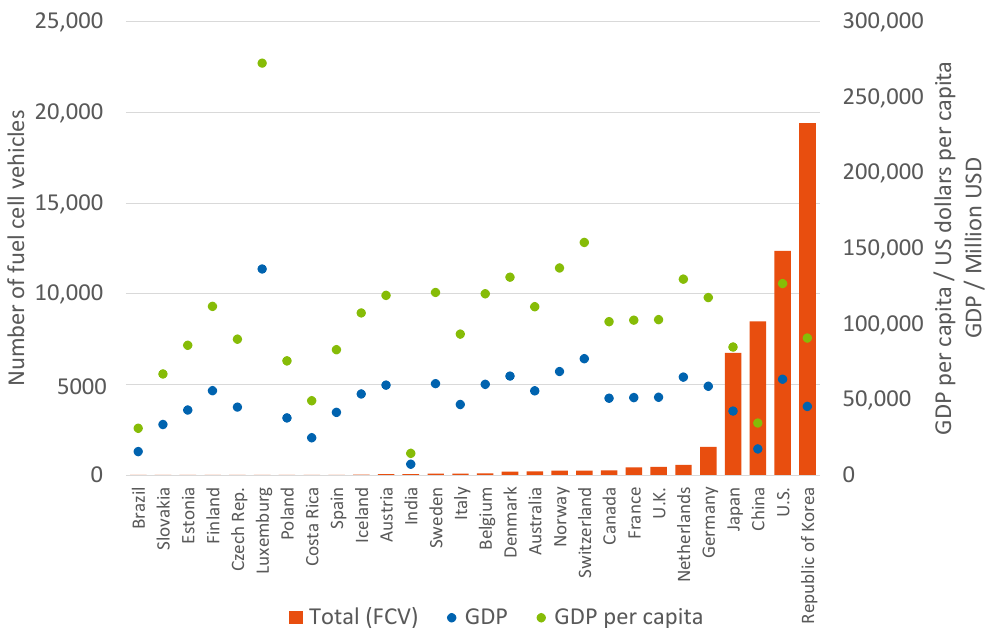
Figure 16. Number of FCVs at the end of 2021 from this work (left) vs. GDP and GDP per capita based on the OECD database (right) [140].